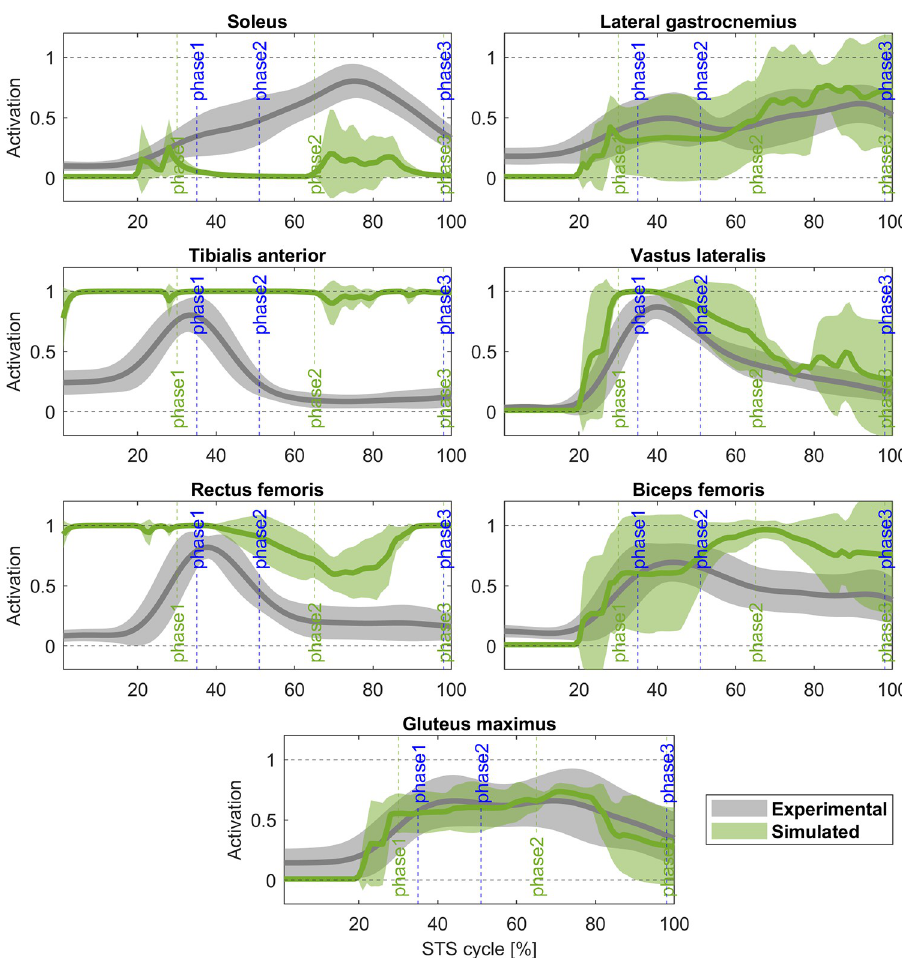
Fig 5. Experimental (grey) and 4-phases controller (green) muscle activation comparison (mean ± std). Activations is normalized between 0.1 (tonic activation) and 1. Blue vertical lines: experimental cycle times; green vertical lines: 4-phases controller cycle times. Cross-correlation coefficient: r(SOL) = 0.45 ( Δ = 0%), r(GAS) = 0.93 ( Δ = 0%), r(TA) = 0.31 ( Δ = 12%), r(VAS) = 0.96 ( Δ = 0%), r(RF) = 0.51 ( Δ = 60%), r(BF) = 0.77 ( Δ = 0%), r(GLU) = 0.96 ( Δ =